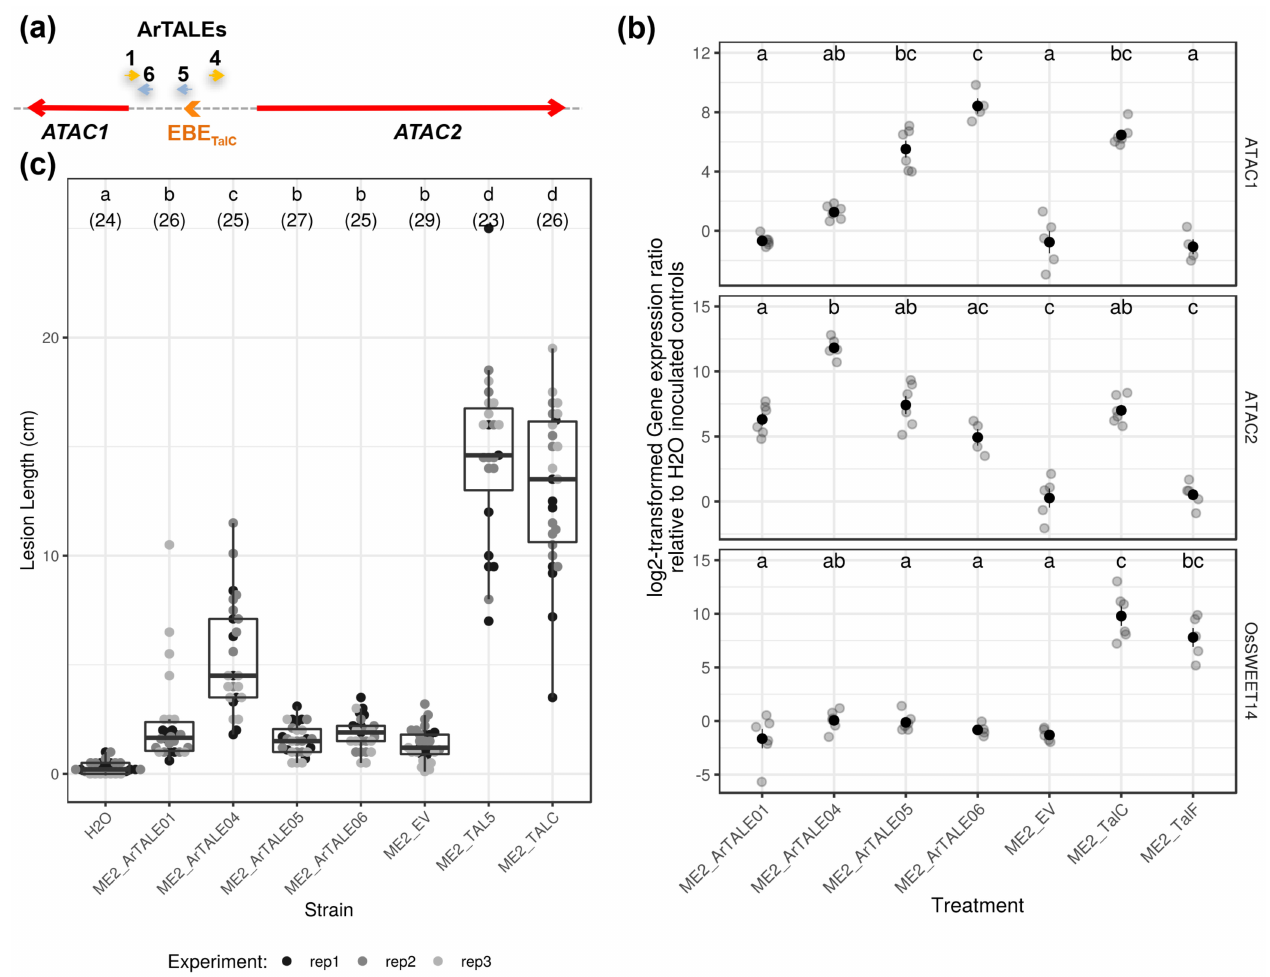
Figure 3. Independent ArTALEs targeting the ATAC loci are functional but do not compensate the loss of clade III OsSWEET induction for the virulence of the Asian PXO99 strain pthXo1 mutant derivative. ( a ) Diagram depicting the orientations (color and arrowhead) and approximate locations of the different EBEs targeted by ArTALEs relative to the ATAC locus transcripts. Numbers on top of ArTALE EBEs identify individual ArTALEs in panels B and C below. ( b ) TalC target transcript expression ratios in response to ArTALEs designed to target the ATAC locus. qRT-PCR was performed with leaf samples collected 48 h post infiltration of the Kitaake wild-type rice line with derivatives of the ME2 (PXO99 mutated in the major TALE gene pthXo1 ) strain carrying an empty vector (EV) or related plasmids encoding the indicated TALEs. The plotted data (gray dots) derive from two independent experiments ( n = 4–6). The black dots and line ranges denote the mean and the standard error, respectively. Treatments with the same letter in an individual transcript panel are not significantly different (Dunn’s test for post hoc pairwise multiple comparisons; p -value < 0.05). ( c ) Lesion length measured on wild-type rice line Kitaake 14 days post leaf clipping inoculation with the indicated strains. The plotted data derive from three independent experiments (dots with different gray levels). Additional water control leaves did not show BLB symptoms. The boxplots represent the median and the first and third quartiles, whereas the whisker extends from the hinge to the largest or the lowest value but no further than 1.5 times the distance between the first and third quartiles. Treatments with the same letter in an individual transcript panel are not significantly different (Dunn’s test for post hoc pairwise multiple comparisons; p -value < 0.05). Numbers in parentheses represent the count of values for the corresponding